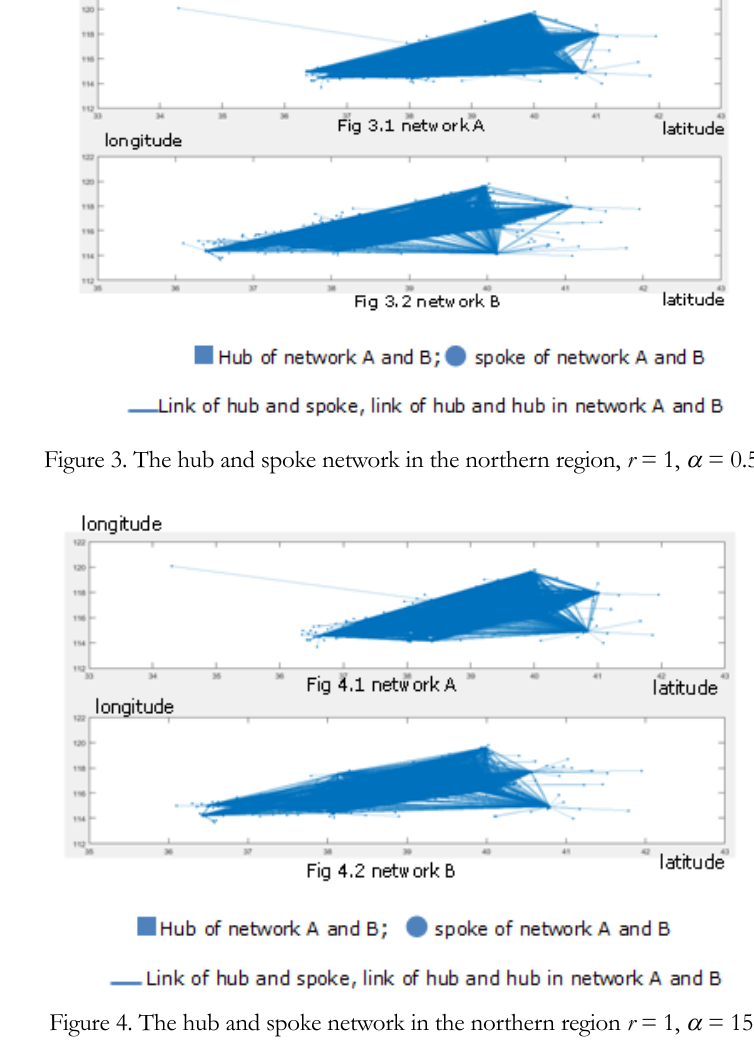
Figure 4. The hub and spoke network in the northern region r = 1,  = 15